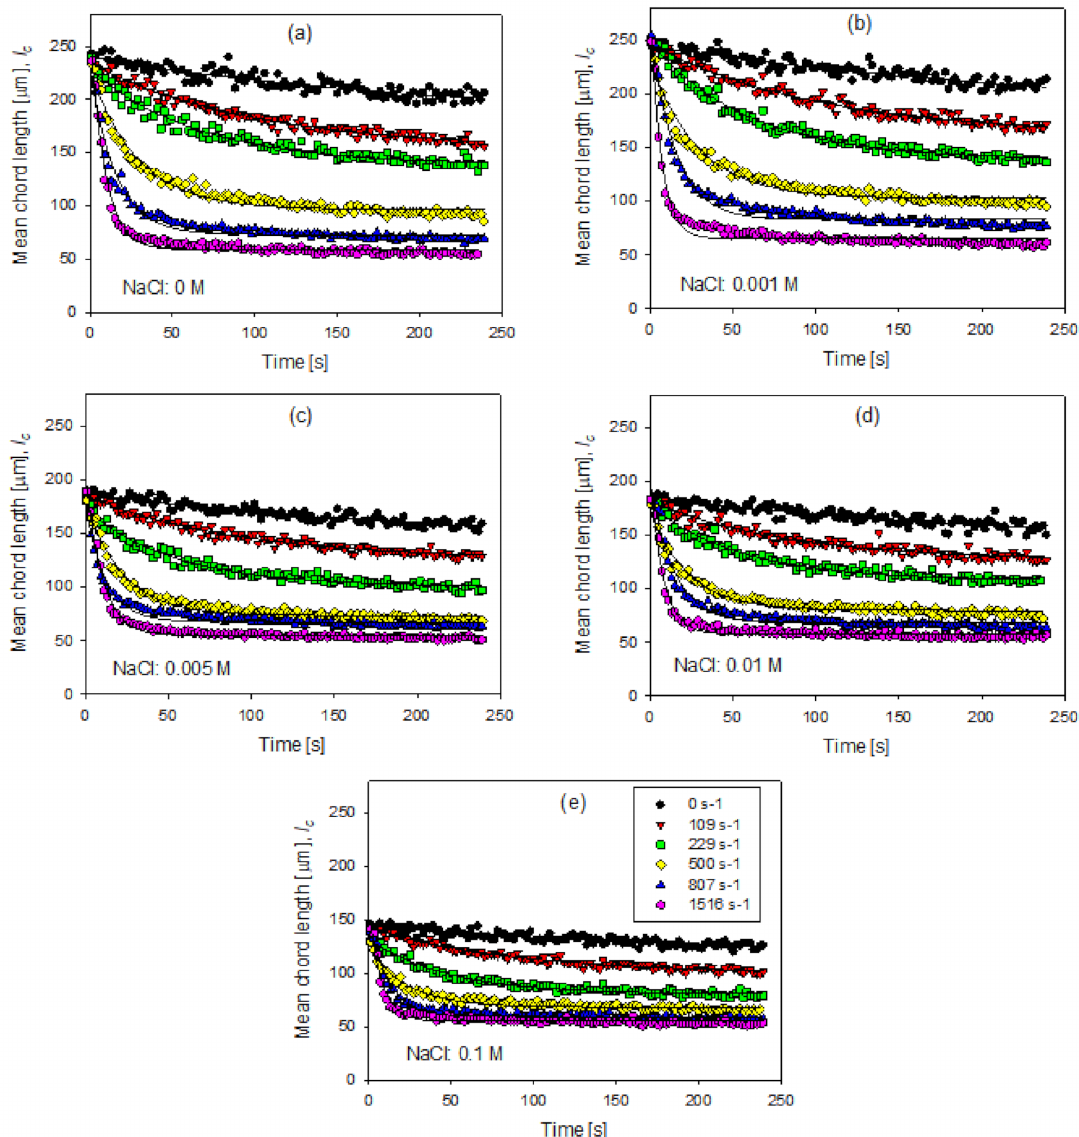
Figure 9. Evolution of the average size of kaolin aggregates in saline solutions (NaCl) after incrementing the shear rate. Experimental data (points) and curve fitting to Equation (7) (continuous